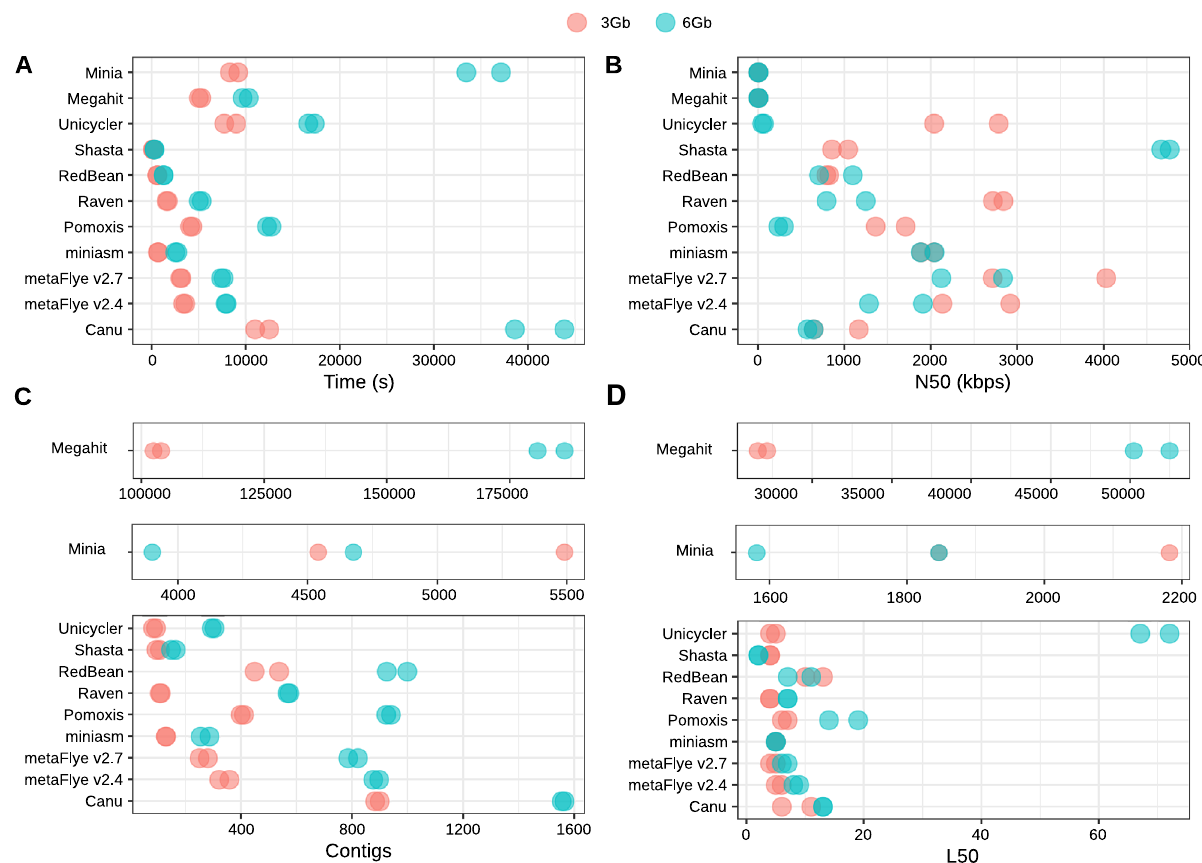
Figure 3. General assembly performance of each tool for the subsampled Even datasets. ( A ) Run time; ( B ) N50; ( C ) number of contigs; ( D )